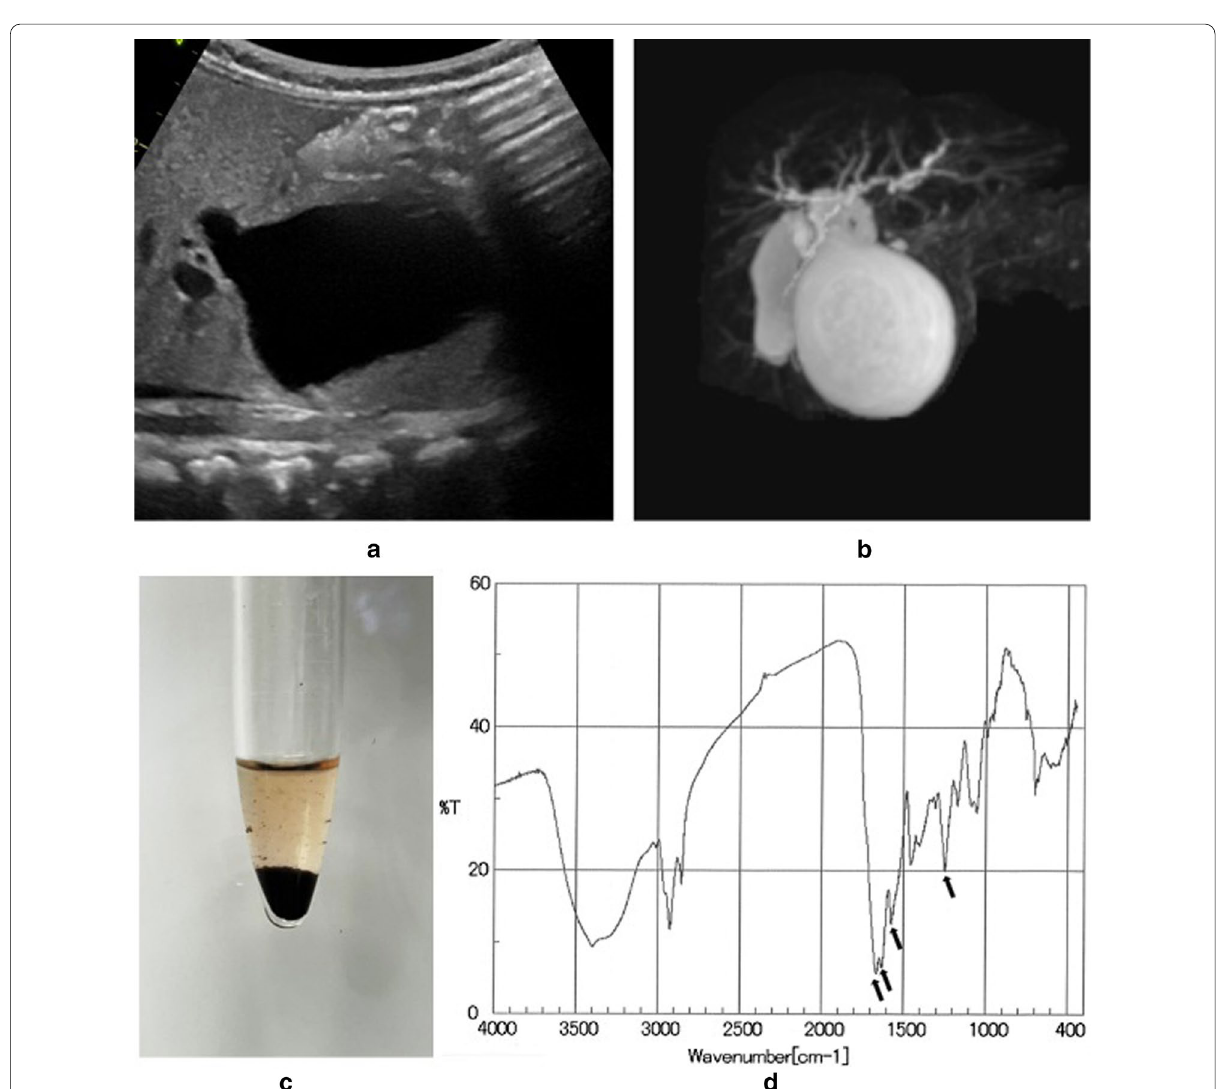
Fig. 3 Data of Case 2. a Ultrasonography detected debris in the cyst. b Magnetic resonance imaging showed a cyst of the common bile duct. c The sludge in the bile duct consisted of fine black particles. d Infrared absorption spectra of the debris. Four major absorption bands (arrows) were characteristic of calcium